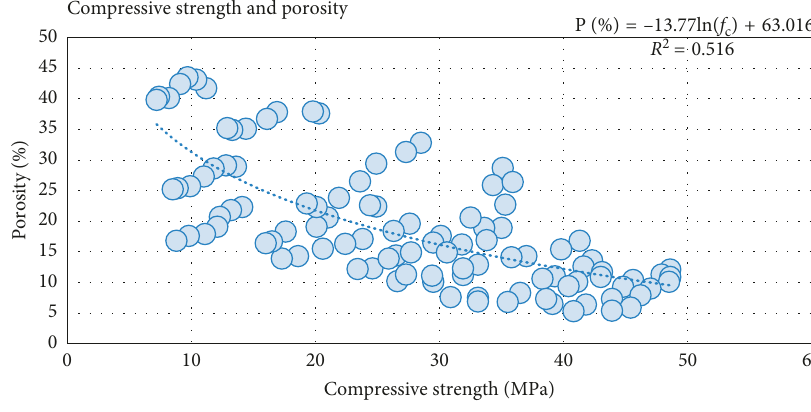
Figure 13: Correlation between porosity and compressive strength of VS-based concretes.